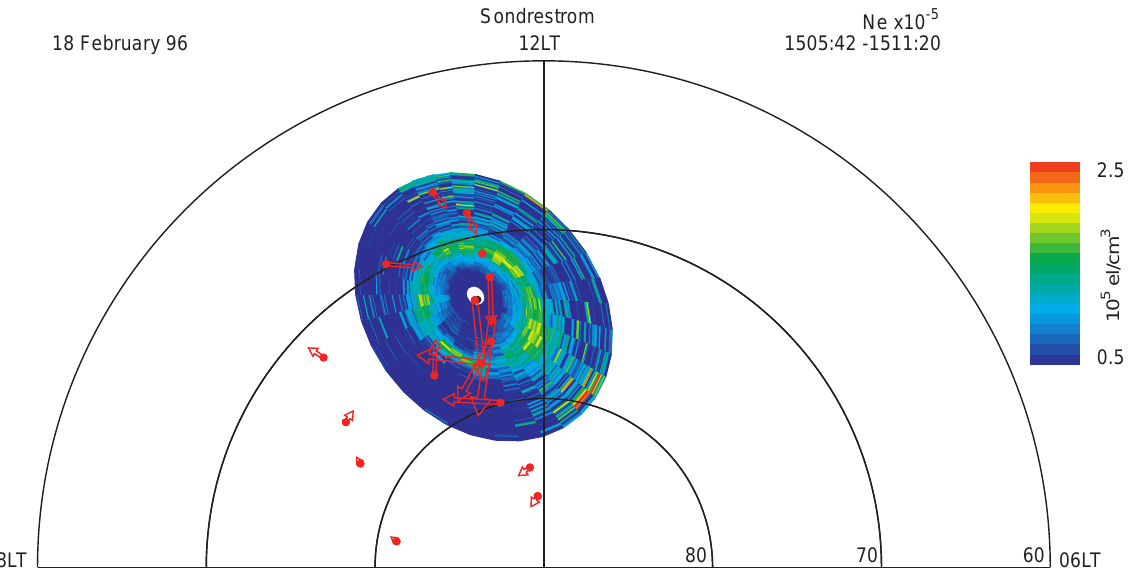
Fig. 9. Plot of the number density measured by the Sondrestrom radar between 1505:42 and 1511:20 UT. Superimposed in red arrows are the equivalent drifts measured by the magnetometers at 1506 UT.